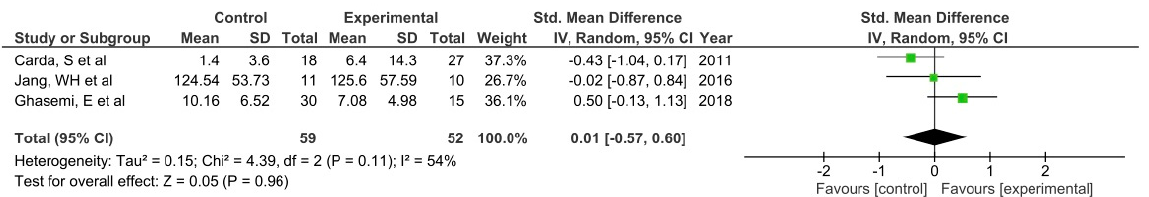
Figure 7. Funnel plot panel of the comparison of the difference between the groups in ROM. Spasticity This variable is the only measurement that exists in all of the studies. The standard scale used was the MAS [46], with scores in the range of 0–4: (0) no increase in muscle tone; (1) a slight increase in muscle tone, manifested by a block and release or by a mini- mum resistance at the end of the ROM when the affected segment moves in flexion or extension; (2) increased muscle tone, demonstrated by a block in the middle of the ROM with effortless movement of the affected party; (3) considerable increase in muscle tone, difficult passive movement; (4) rigid parts affected in flexion or extension. This is the most